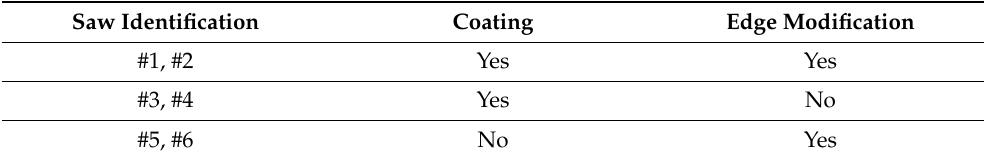
Table 3. Saw identification for industrial